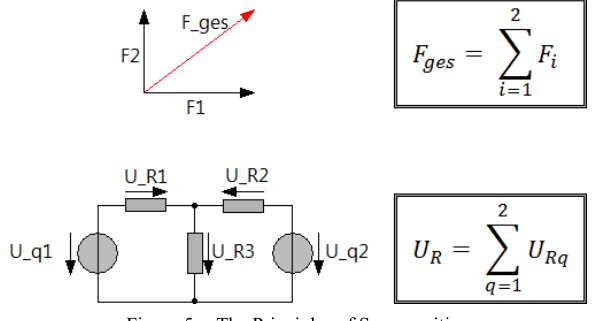
Figure 4. Picture of a Lab Problem